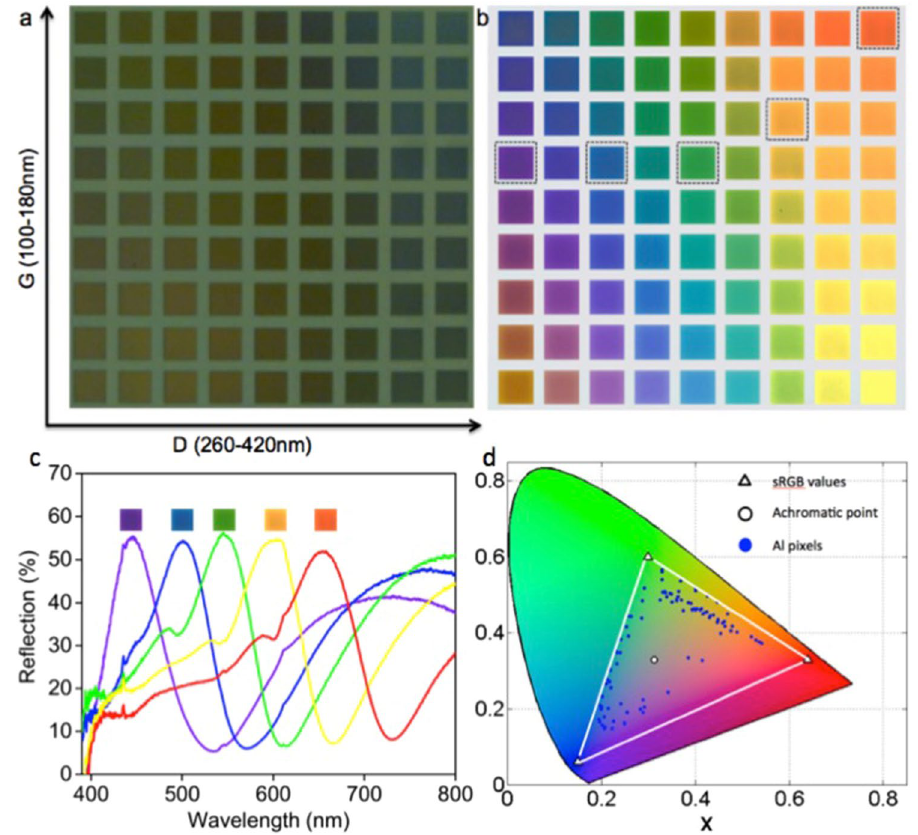
Figure 2. Optical micro-images and spectral analyses of the colour pallets with varying square size D and gap size G. Each pallet of 20 μ m square consists of 2D arrays of sub-micron structures arranged in a square lattice. The size of the Al square patch D varies from 260 nm to 420 nm with an increment of 20 nm in the horizontal axis and the gap size G varies from 100 nm to 180 nm with an increment of 10 nm in the vertical axis. ( a ) PMMA nano pillars arranged in the square lattice show no colouration before metal deposition. ( b ) After the deposition of thin Al layer of uniform thickness, the pallets displayed bright and distinct colours depending on the geometrical parameters D, G and P. ( c ) Experimental reflection spectra of selected pallets (highlighted within the black boxes in ( b )) captured using micro-spectroscopic technique. ( d ) Corresponding positions of all colours in ( b ) plotted in the CIE1931 colour space. The blue circles represent the tristimulus values of the aluminum colour pixels, which are scattered far from the achromatic point represented by the white circle. The blue circles formed a ring around the achromatic point confirming the capability of the proposed plasmonic geometry for the generation of full colours with high colour saturation. The x and y values for the primary colours red, green and blue are 0.5421; 0.3738, 0.3290; 0.5679 and 0.1951; 0.1722 respectively and are comparable with that of the sRGB values 0.6400; 0.3300, 0.3000; 0.6000 and 0.1500; 0.0600 common to all displays, represented by the white triangles in the